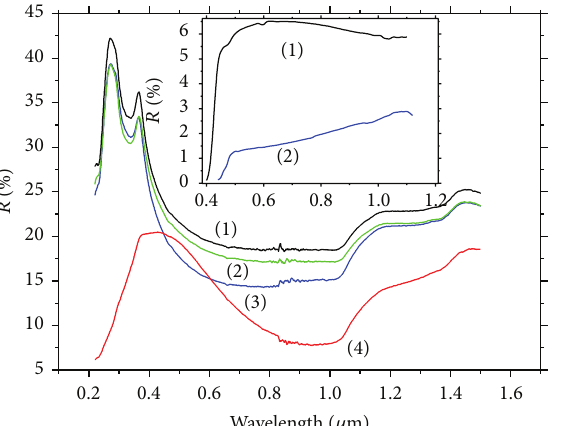
Figure 5: Normal incidence diffuse reflection of a set of MJ Si-SCs: (1)—initial; (2)—after RF treatments (back side of SC); (3)—after RF treatments (front side of SC); (4)—after plasma treatments and deposition of DLCF. Inset: Normal incidence specular reflection of a series of MJ Si-SCs: (1)—initial; (2)—after plasma treatments and deposition of DLCF.